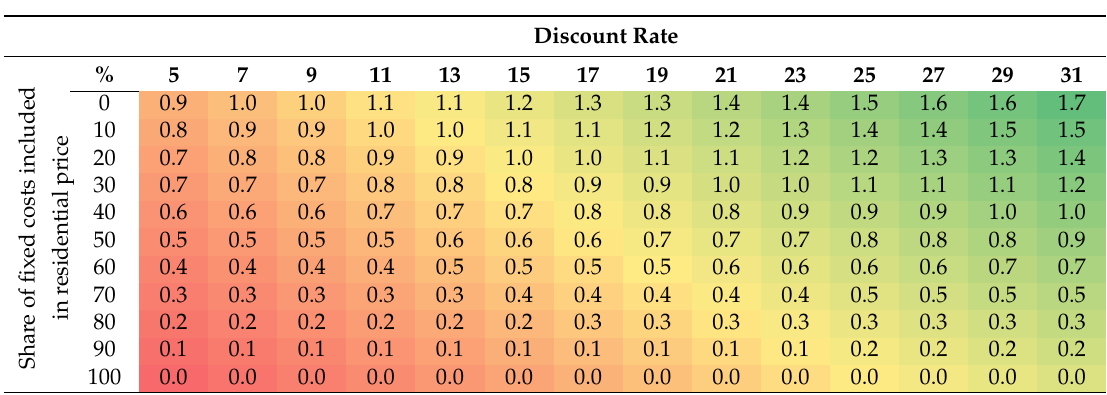
Table 7. Resident blocking tari ff rate in EUR /